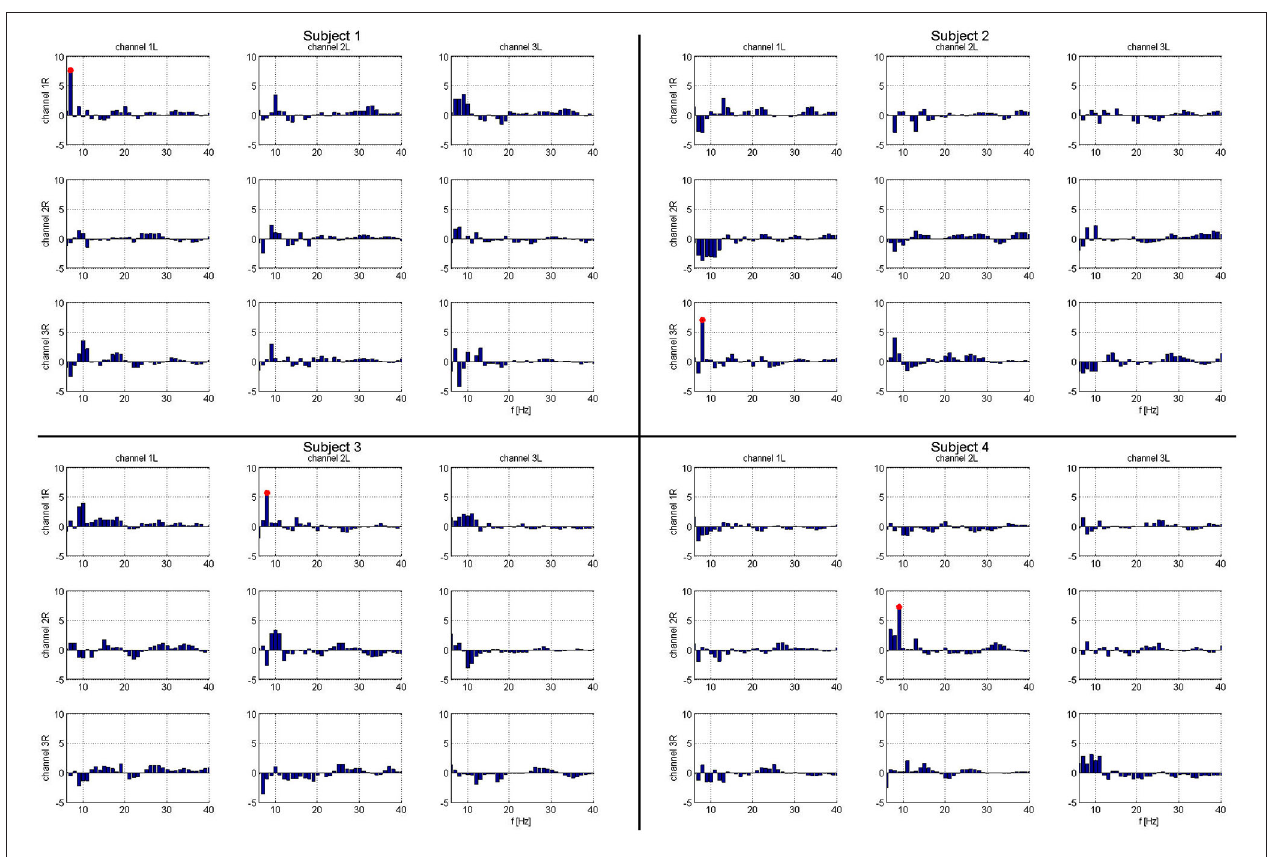
each left-right STN channel pair and subject. Frequencies marked in red are significant at a corrected p < 0.05. For each subject, there is exactly one combination of electrodes with significant phase